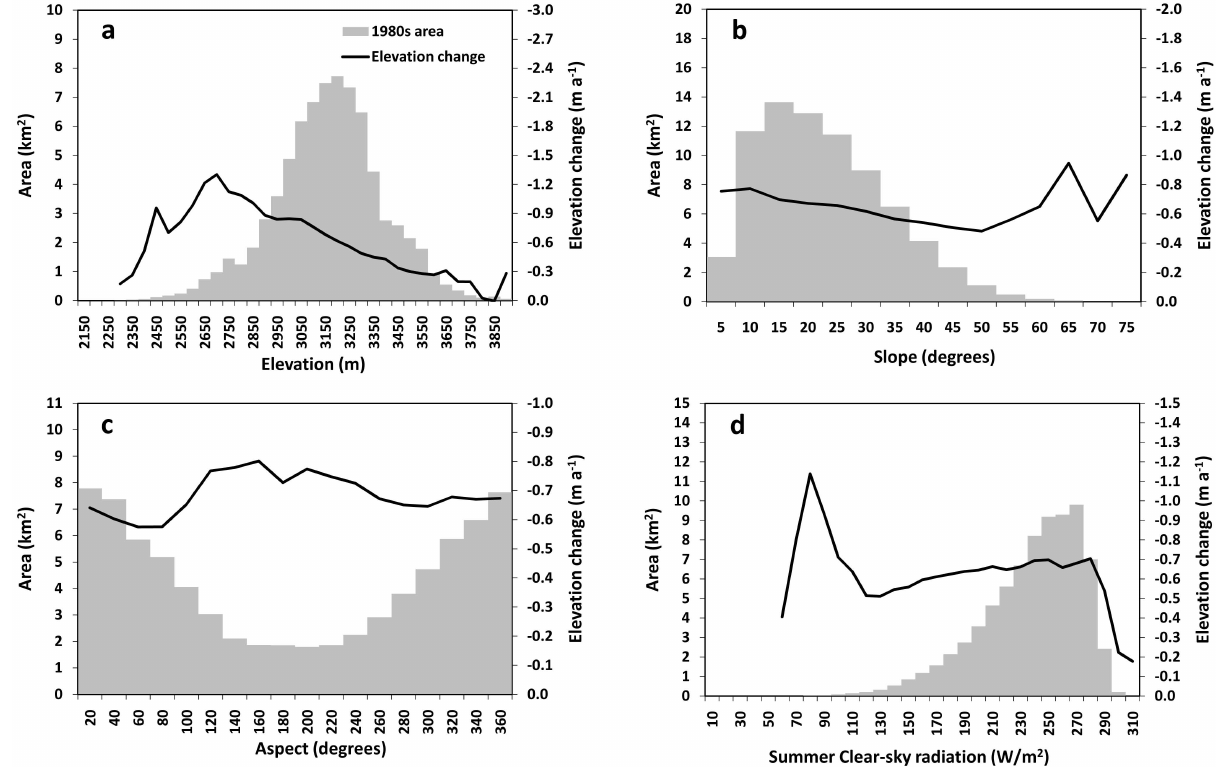
Fig. 11. Elevation changes of the Ortles-Cevedale glacier system from the 1980s to the 2000s, for classes of (a) elevation, (b) slope, (c) aspect and (d) summer clear-sky radiation. Calculations were performed over the 2000s glacierized area. The area distribution in the 1980s is shown to give a background for the reported elevation